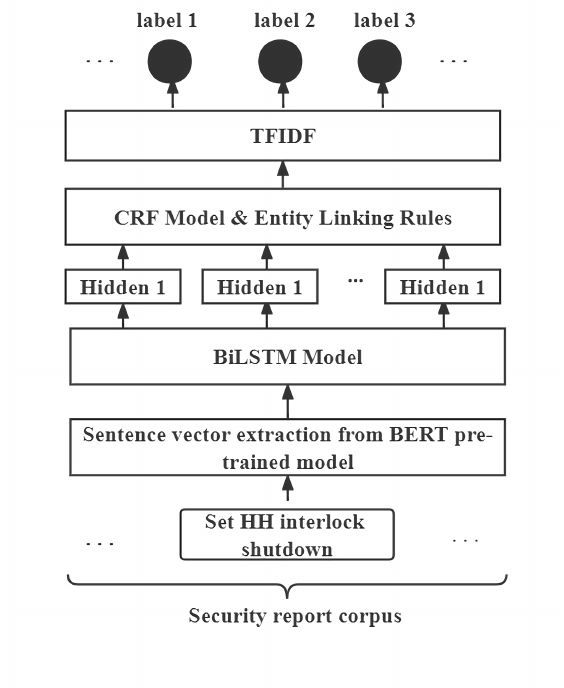
Figure 2. Overall structure diagram of